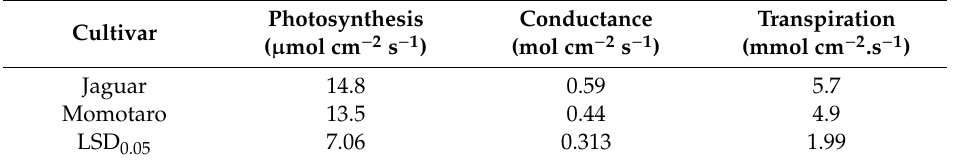
Table 3. Physiological response of tomato to LN&HD at 42 DAT.